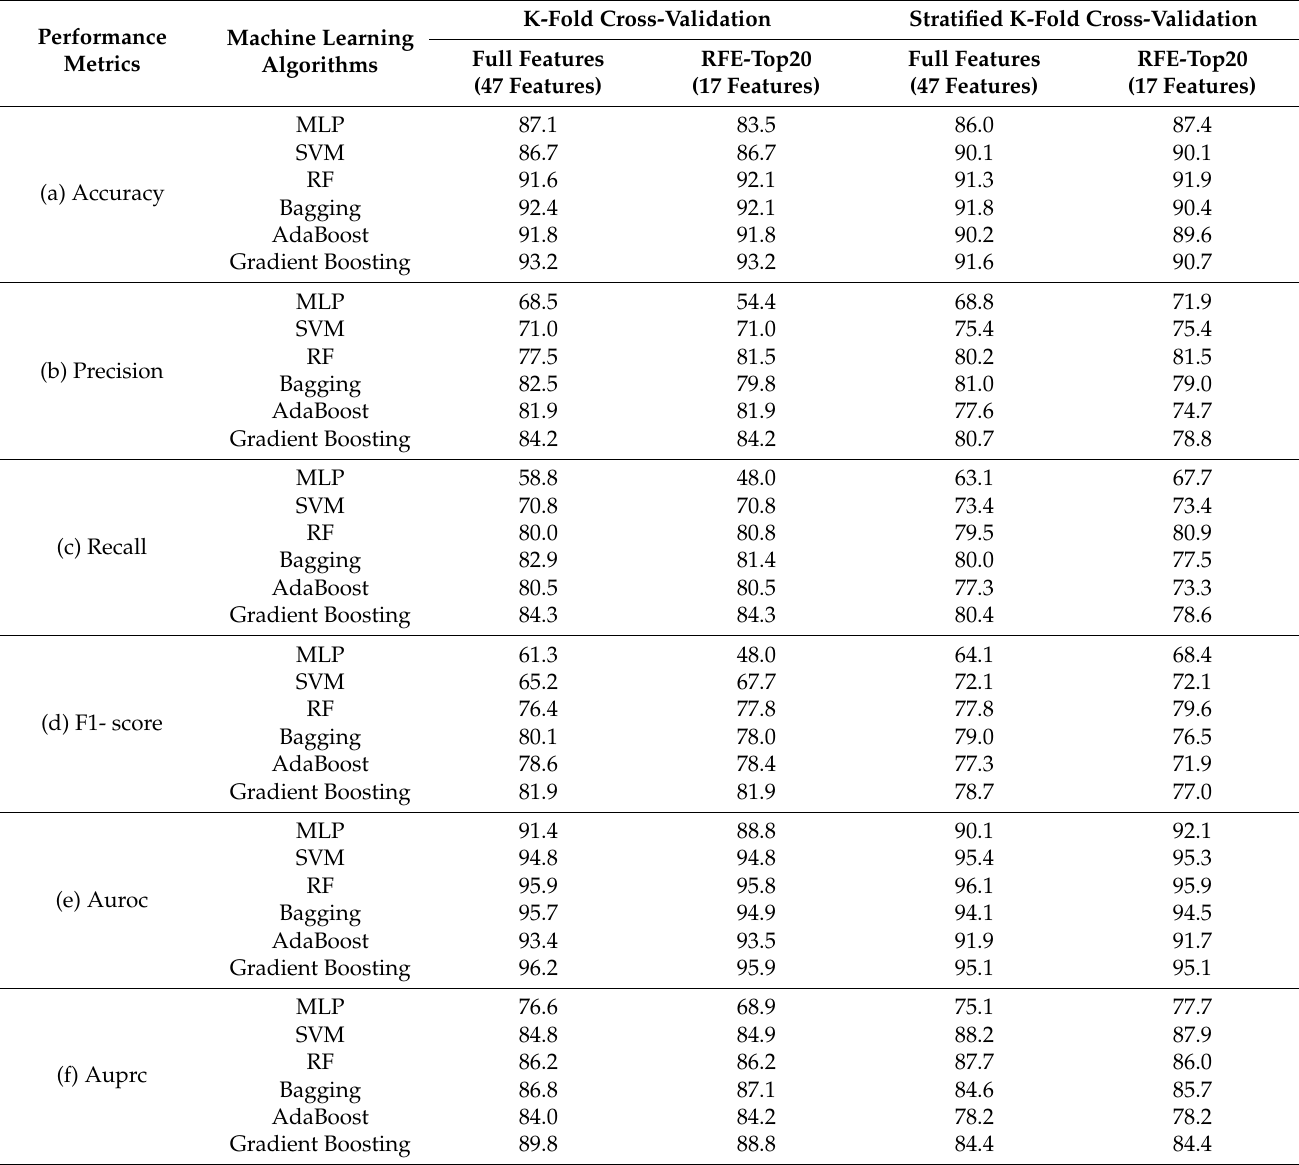
Table 7. Accuracy, precision, recall, F1-score, auroc, and auprc using the full features and selected features on the stadium fire dataset using five-fold